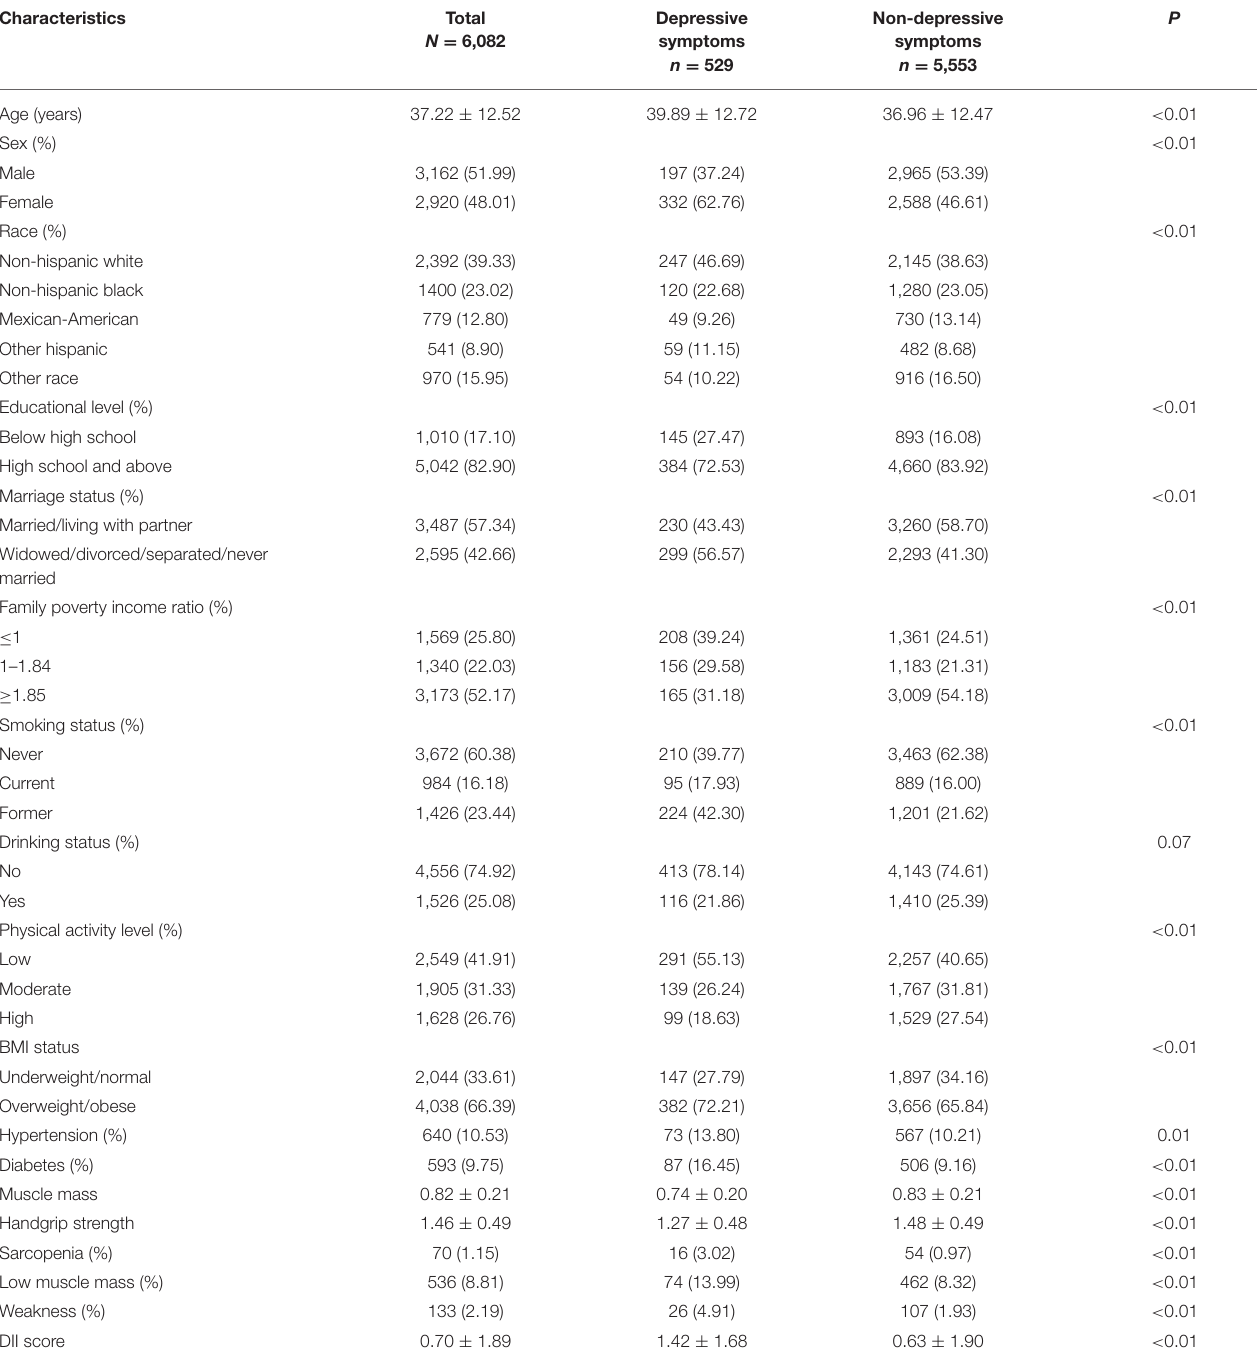
TABLE 1 | Sample characteristics stratified by depressive symptoms.